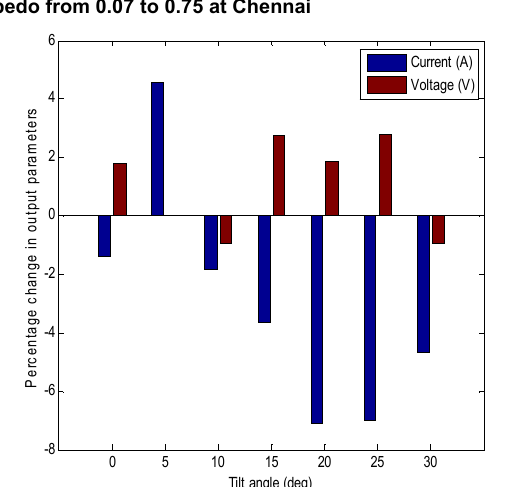
Figure 6(c). Percentage change in output parameters (Current and Voltage) with tilt angle for increases in ground albedo from 0.07 to 0.75 at Bengaluru